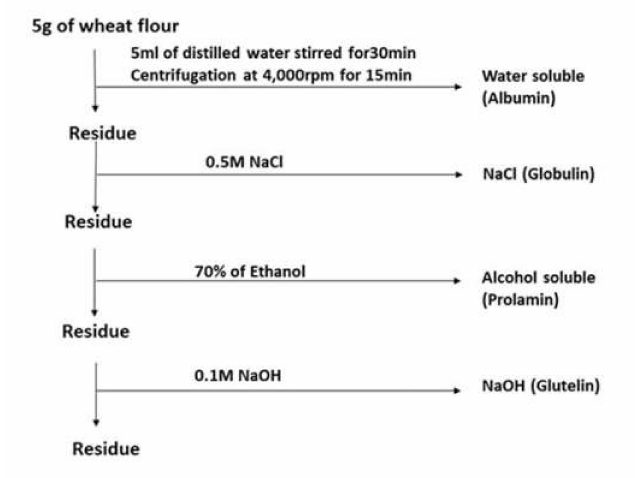
Figure 3. The flow sheet of the protocol used for protein